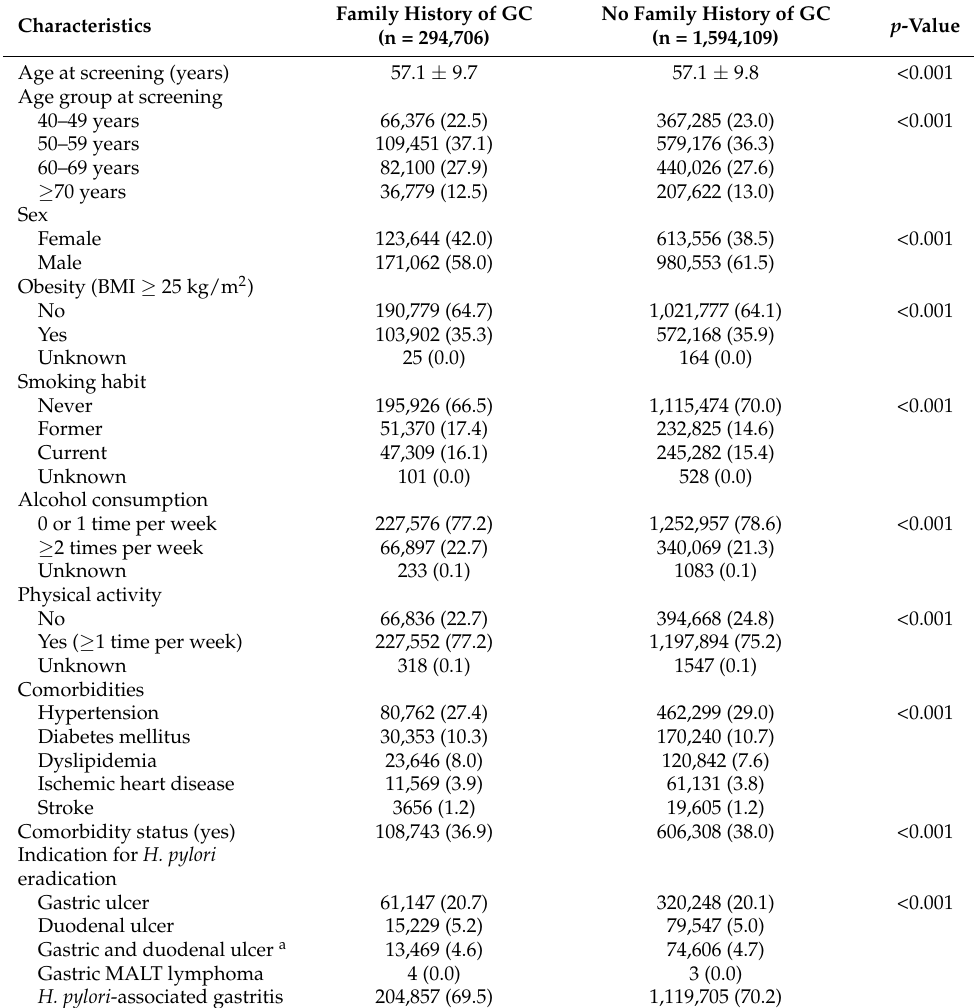
Table 1. Baseline characteristics of all H. pylori -treated